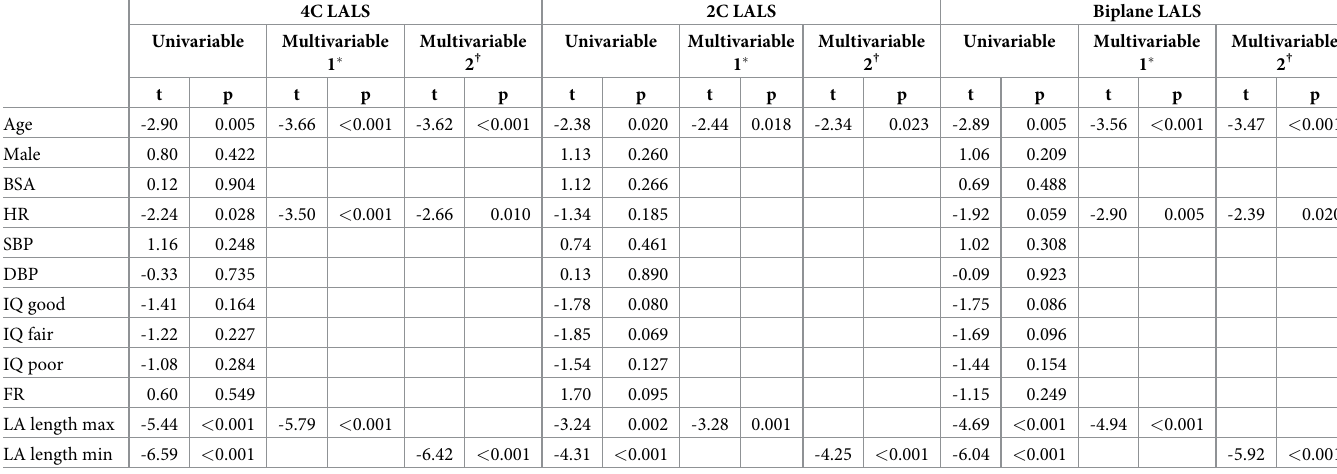
Table 5. Univariate and multivariate linear regression analysis for the association of anthropometric and echocardiography parameters with left atrial longitudinal strain assessed with 2D echocardiography in 53 patients having cardiovascular diseases. 4C LALS